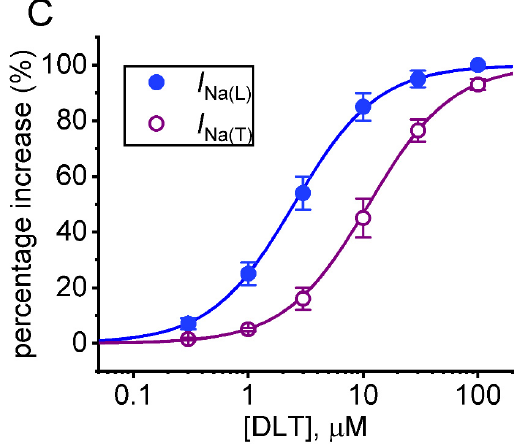
Figure 1. Effect of deltamethrin (DLT) or tefluthrin (Tef) on voltage-gated Na + current ( I Na ) measured from pituitary GH 3 lactotrophs. This set of experiments was made in cells placed in Ca 2+ -free, Tyrode’s solution containing 10 mM tetraethylammonium chloride (TEA), and the measuring elec- trode was filled with an internal solution enriched with Cs + . ( A ) Exemplar current traces obtained in (a, blue color) the control conditions (i.e., neither DLT nor Tef was present) and during cell expo- sure to either 10 μ M DLT (b, upper, red color) or 10 μ M Tef (b, lower, red color). The voltage-clamp protocol is illustrated atop recorded current traces. The graph shown in the right side of ( A ) denotes the expanded record from the observed current trace (red color) in the presence of 10 μ M DLT and the definition of transient Na + current ( I Na(T) ), late Na + current ( I Na(L) ), total Na + current ( I Na(Tot) ), or tail Na + current ( I Na(Tail) ) is marked (indicated with blue double arrows). ( B ) Time course of effects of 10 μ M DLT on the amplitude of I Na(Tot) (upper), I Na(L) (middle), and I Na(T) (lower) . Each point was taken at a rate of 0.1 Hz. The horizontal bar shown above indicated the application of DLT. ( C ) Concen- tration-dependent relationship of DLT on I Na(T) (purple open circles) or I Na(L) (blue solid circles) acti- vated by short depolarizing step. Each data point in this graph represents mean ± SEM of 9 cells. According to the averaged data, the smooth line represents the best fit to the Hill equation as de- scribed in Materials and Methods.